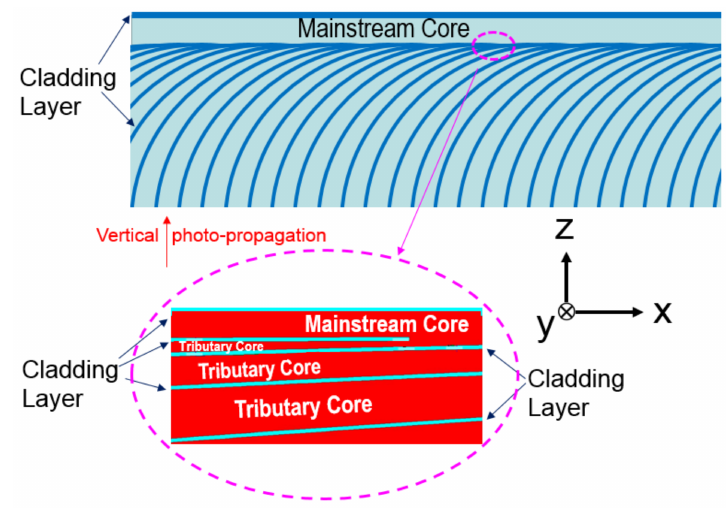
Figure 6. Asymmetric waveguide with discrete translational symmetry (top) and at bottom is enlarged view of the part where the tributary curved WGs merge into the 2D planar WG (mainstream).